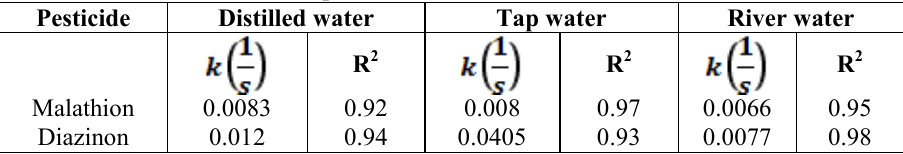
process at various waters.